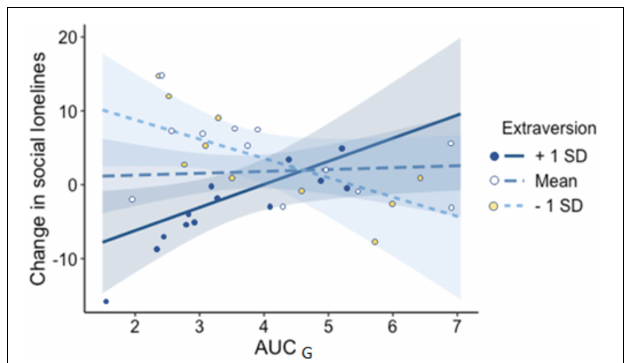
FIGURE 4 | Simple slopes plots of conditional effects representing the association between pre-Extraversion and pre-lockdown cortisol AUC G . AUC G , cortisol index for area under curve from ground; SD, standard